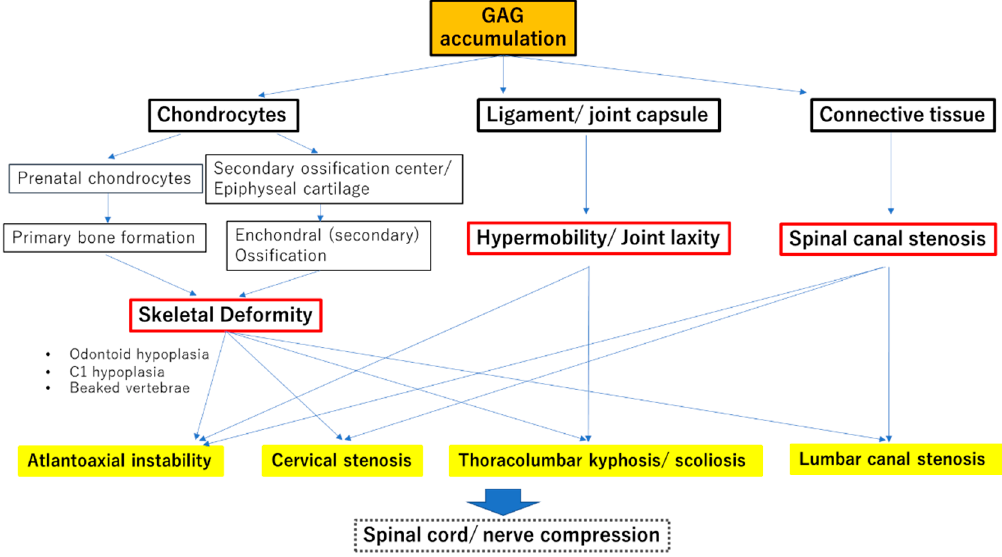
Figure 1. Pathophysiology of spinal cord / nerve compression in mucopolysaccharidoses (MPS). Pathophysiology of all spinal problems in MPS are accountable by combination factors of skeletal deformity, hypermobility / joint laxity, and spinal canal stenosis. Skeletal deformity including odontoid hypoplasia, C1 hypoplasia and other vertebral deformities is caused by glycosaminoglycan (GAG) accumulation in chondrocytes of primary / secondary ossification centers. It starts in prenatal period and continues until bone growth stops. Every spinal problem in MPS is based on skeletal deformities. GAG accumulation in spinal ligament and capsule of facet joints, inducing inflammation and degradation of surrounding tissue, can result in hypermobility and joint laxity, whereas that occurred in connective tissue in anterior extradural space and ligamentum flavum leads to spinal canal stenosis. Atlantoaxial instability is caused by skeletal deformity, hypermobility, and spinal canal stenosis, though the lack of instability leads to cervical stenosis. Skeletal deformity is the first and fundamental factor of all spinal problems. Thus, early diagnosis and intervention is necessary to avoid skeletal deformity and further deterioration of spinal cord / nerve.